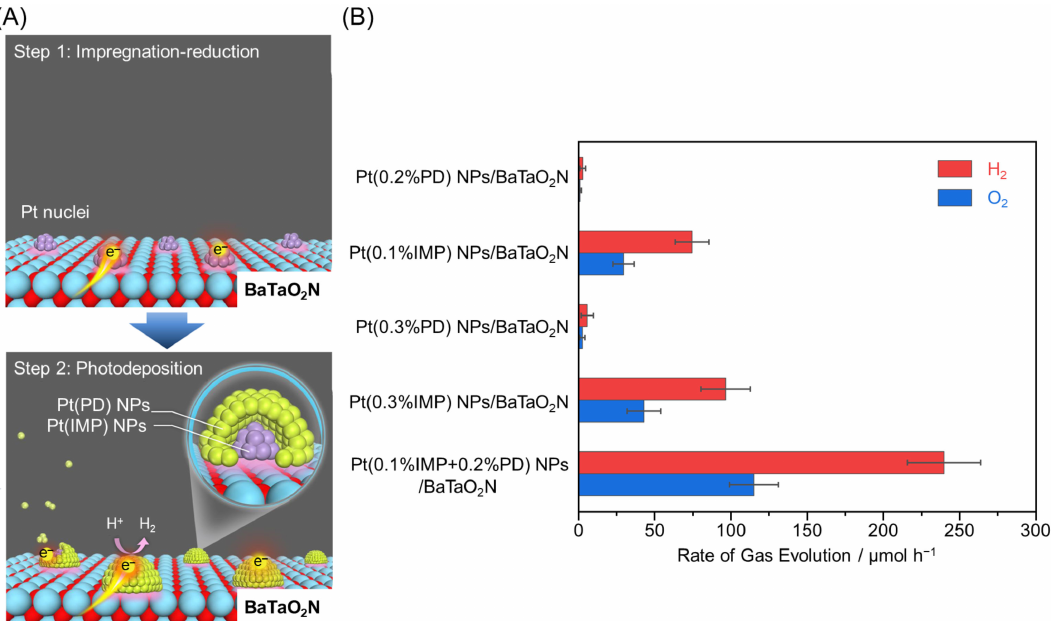
Figure 27. ( A ) Interaction between Pt NPs and BaTaO 2 N photocatalyst. Schematic of sequential Pt NPs cocatalyst deposition on BaTaO 2 N. ( B ) H 2 and O 2 evolution rates during Z-scheme water- splitting reaction using Pt NPs/BaTaO 2 N as the HER photocatalyst. For example, Pt (0.2% PD) NPs and Pt (0.1% IMP) NPs represent Pt NPs loaded on BaTaO 2 N by photodeposition and impregnation methods, respectively. Error bars indicate standard deviation of three measurements. Conditions: Pt NP/BaTaO 2 N photocatalyst, 0.1 g; surface-treated WO 3 , 0.15 g; 1 mM of aqueous NaI solution, 150 mL; light source, 300 W Xe lamp ( λ ≥ 420 nm) or solar simulator (AM1.5G); irradiation area for solar simulator, 7.6 cm 2 ; reaction system, Pyrex top-illuminated vessel connected to the closed gas-circulation system with the periodical evacuation of gas products. Reproduced with permission from reference [225]. Copyright 2021 Springer Nature Limited.